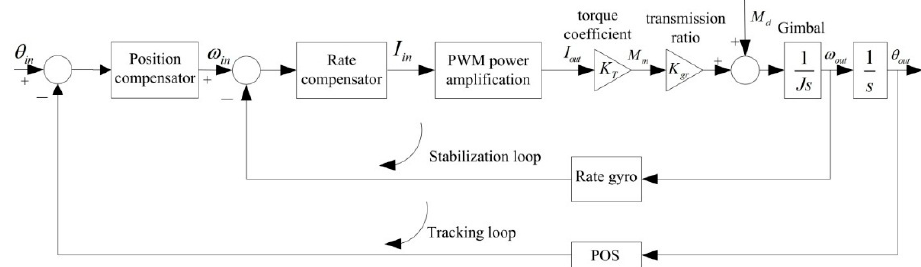
Figure 4. Schematic diagram of dual closed-loop PID control structure.